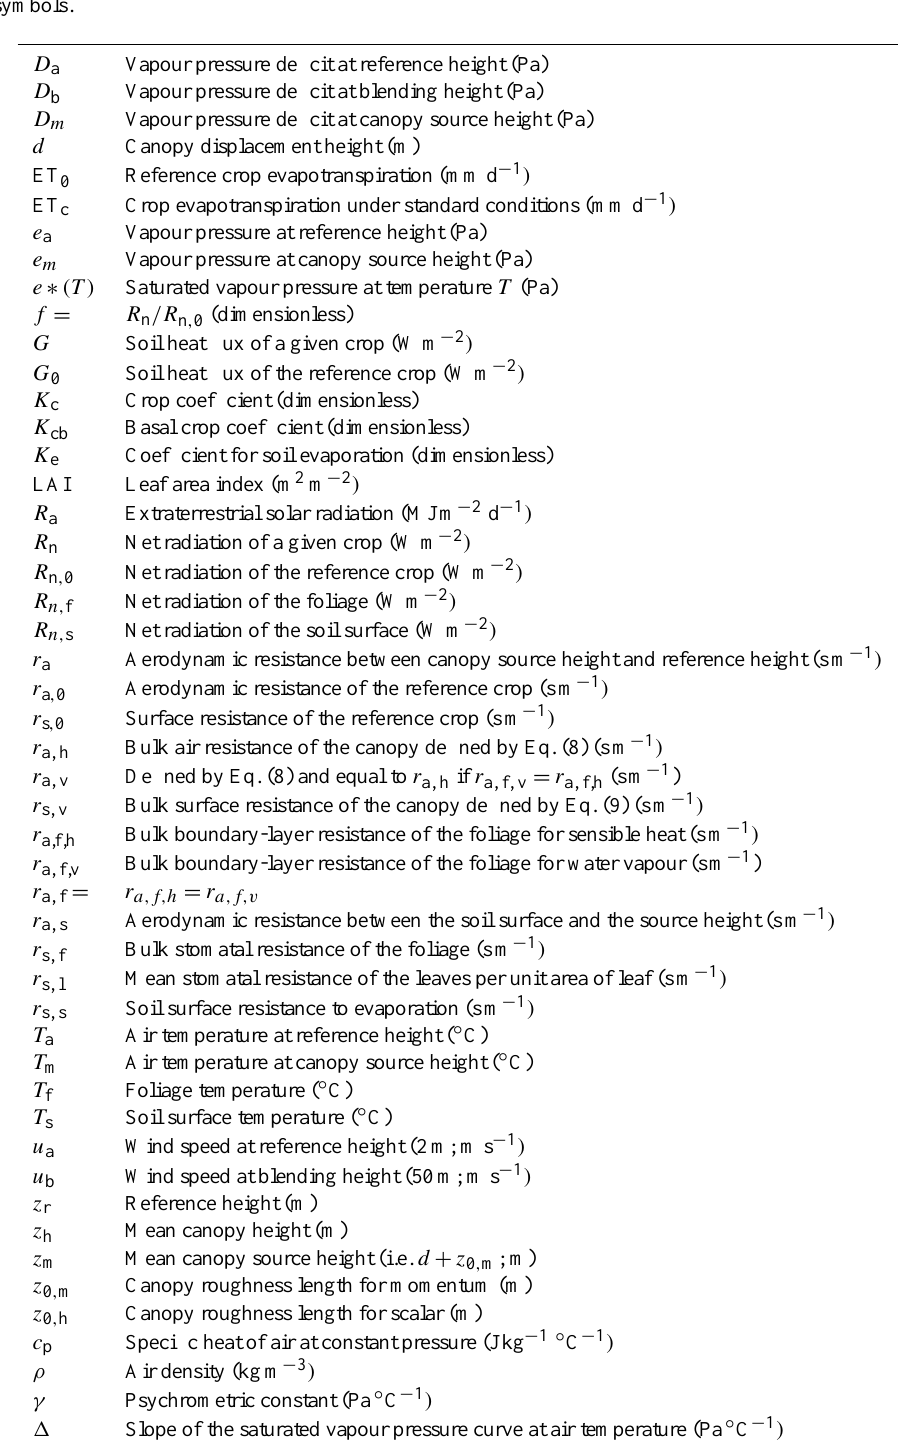
Table A1. List of